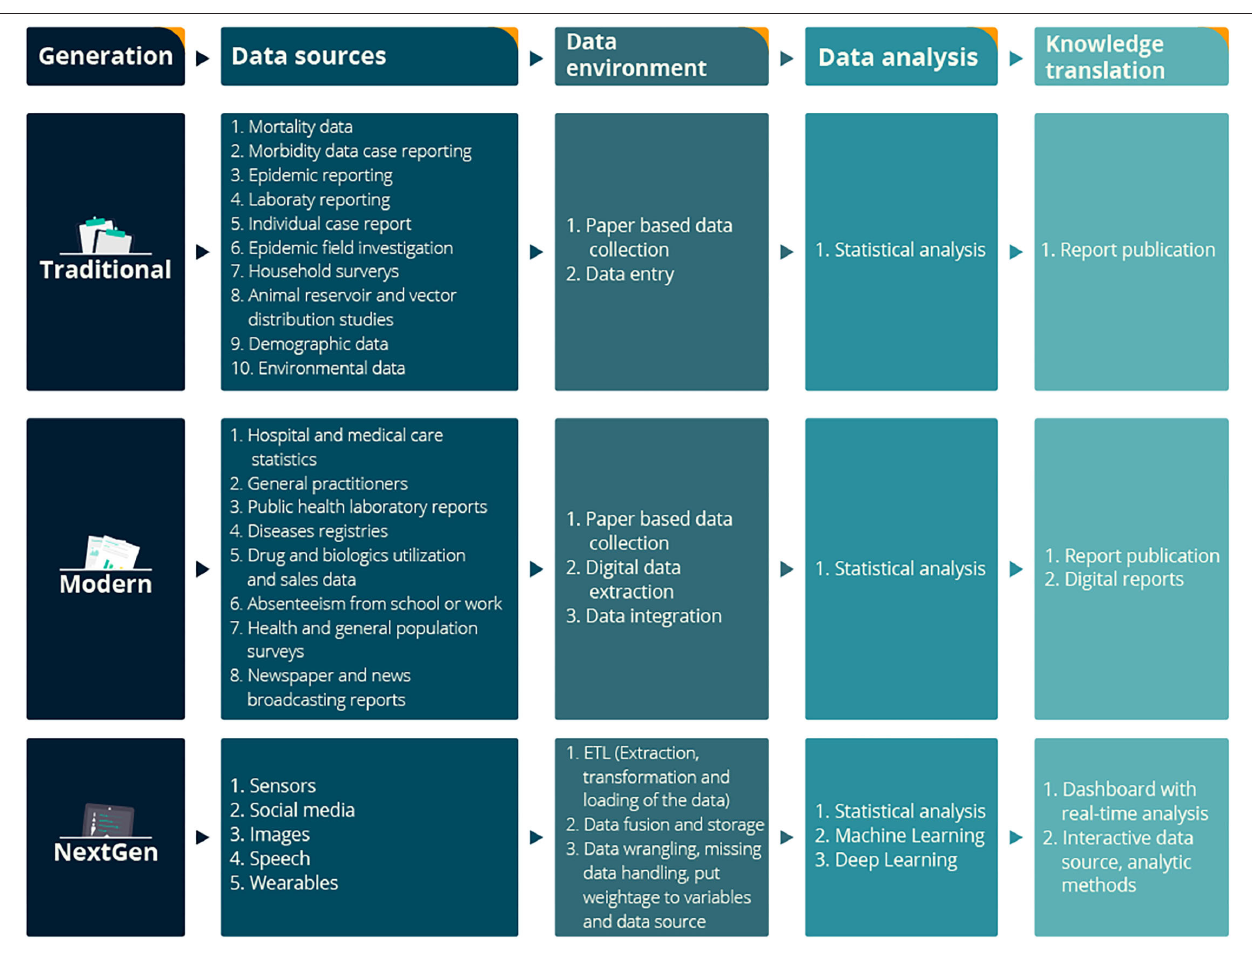
wearable devices, and Radio-Frequency Identification (RFID) tags